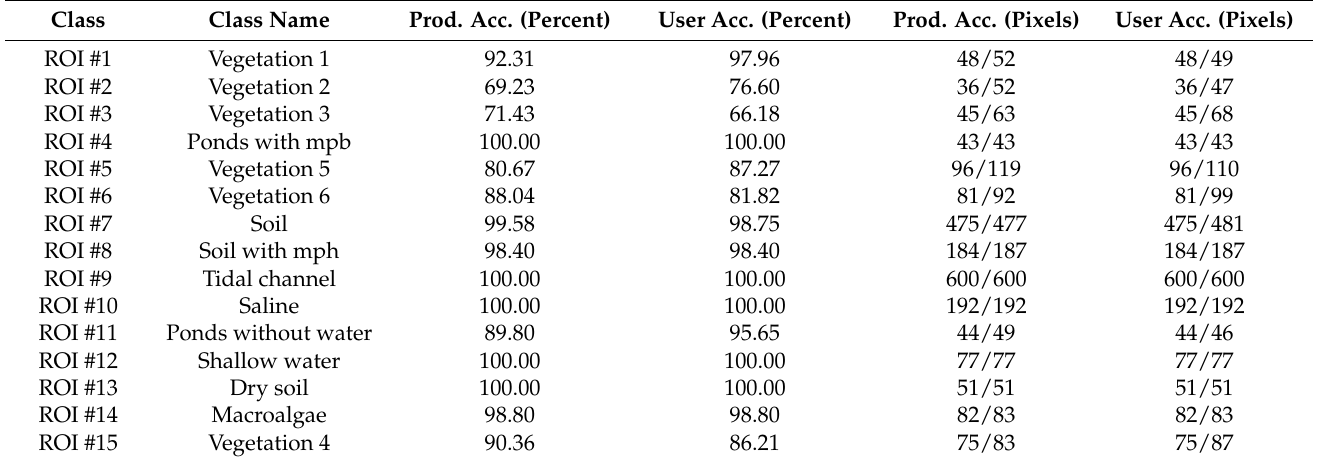
Table A6. Report for the accuracy of the comparison of classification results to Sp10, the stratified- proportionate samples group using 10% of total pixels as reference. The table summarizes the producer accuracy and user accuracy in percentage and pixels for each class.